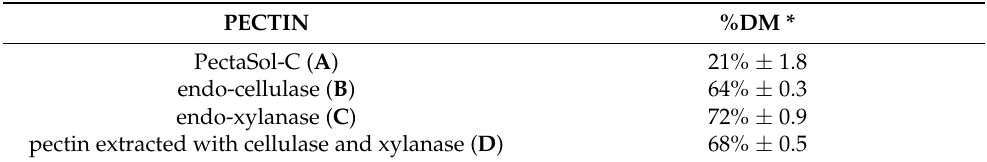
Table 2. The degree of methylation in pectins.